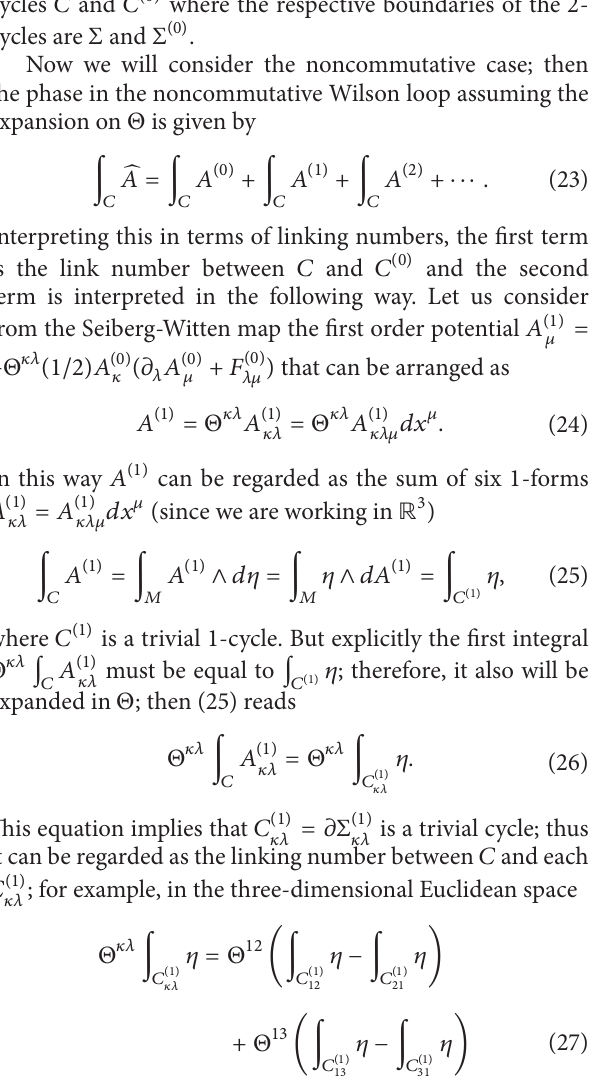
Figure 1: The figure accounts the computation at the first order in Θ of the linking number. For the case of knots in R 3 it is observed at this order that the noncommutativity induces the existence of 6 differentknots,representedinthesimplestcasebycirclesofdifferent colors 𝐶 (1) 𝜅𝜆 , that intersect the original trivial homology 1 -cycle 𝐶 . At the 𝑛 thordertherewillbe 6 𝑛 knotsintersecting 𝐶 .Inthegeneralcase the knots 𝐶 (1) 𝜅𝜆 would be real knots linked, for instance, the trefoil or even more complicated